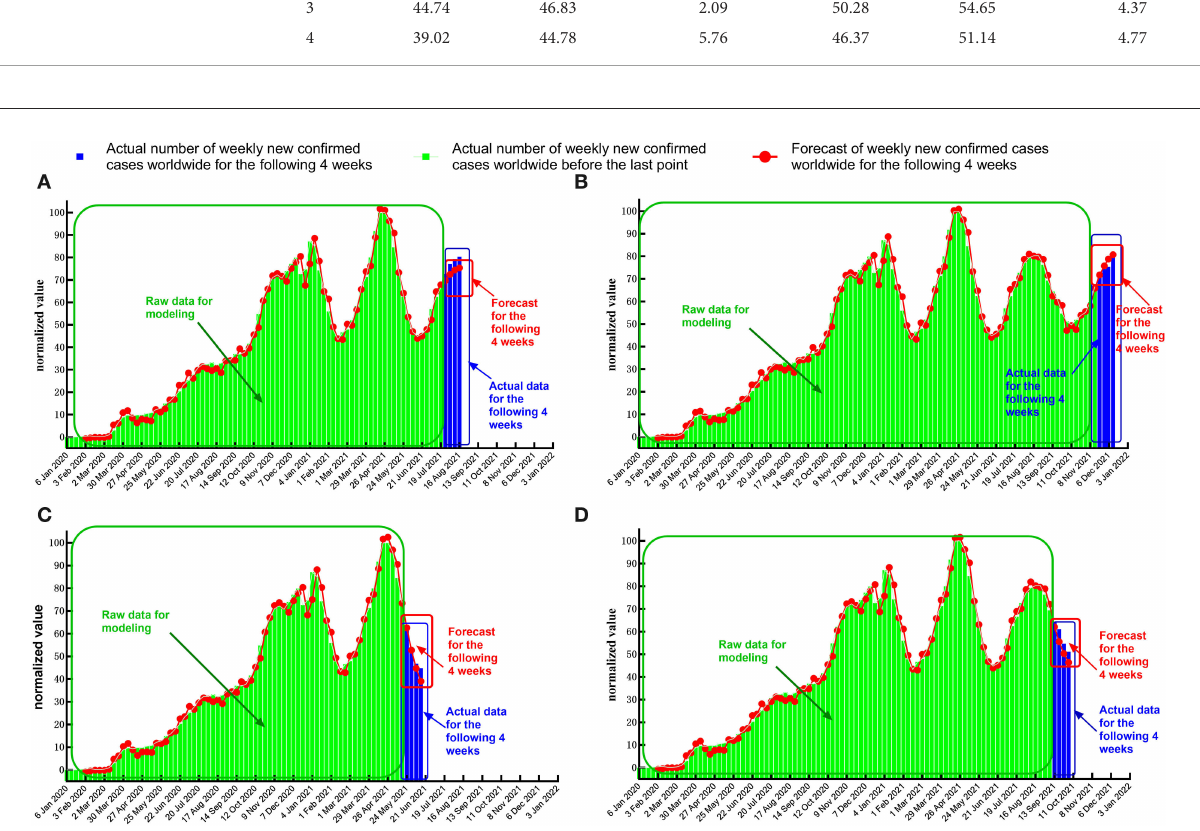
Mid-point of the downtrend